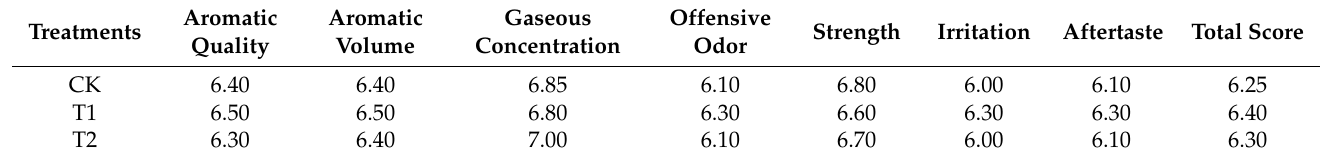
Table 4. Comparison of sensory quality evaluation of flue ‐ cured tobacco (score).